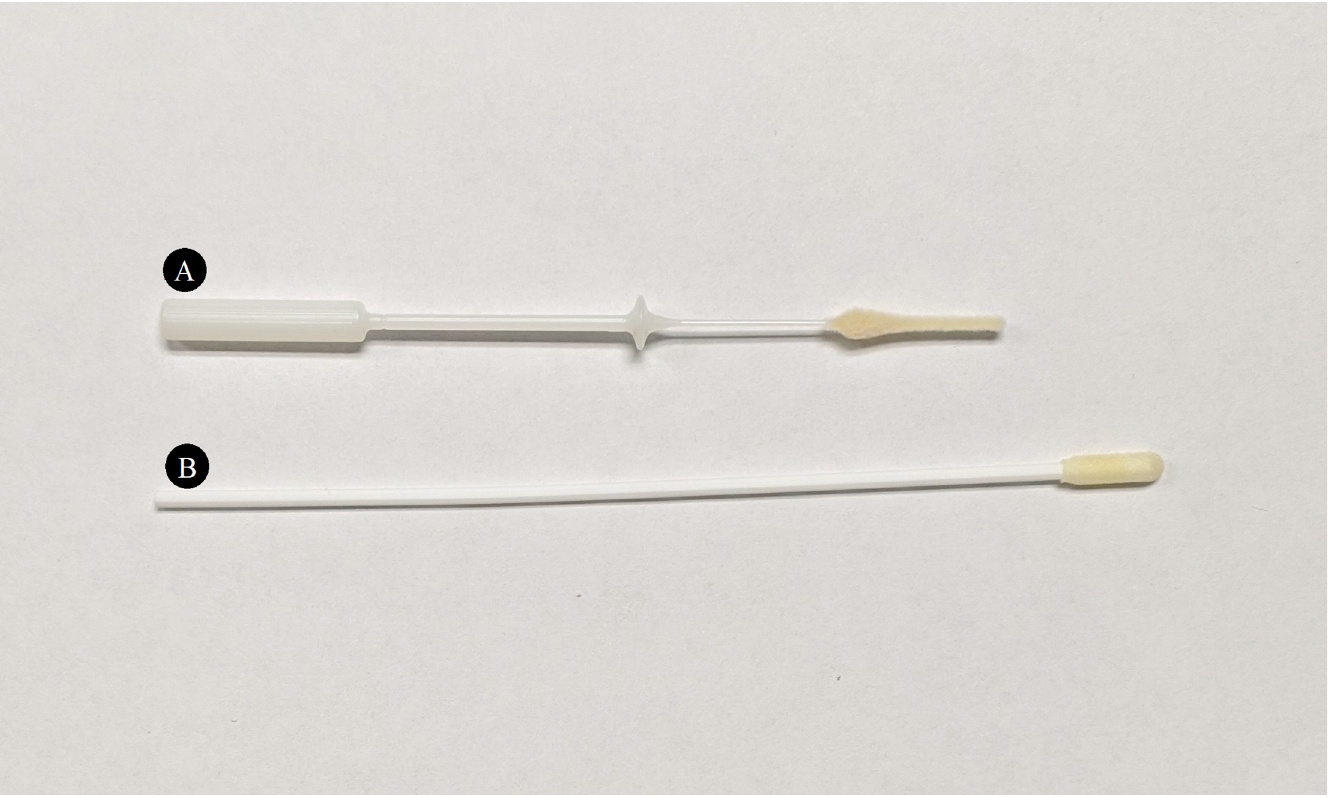
Fig 1. Comparison of the midturbinate swab and the anterior nasal swab. Photograph of the (A) Copan FLOQSwabs ™ flocked midturbinate swab and the (B) anterior nasal Puritan 1 Sterile Foam Tipped Applicator.